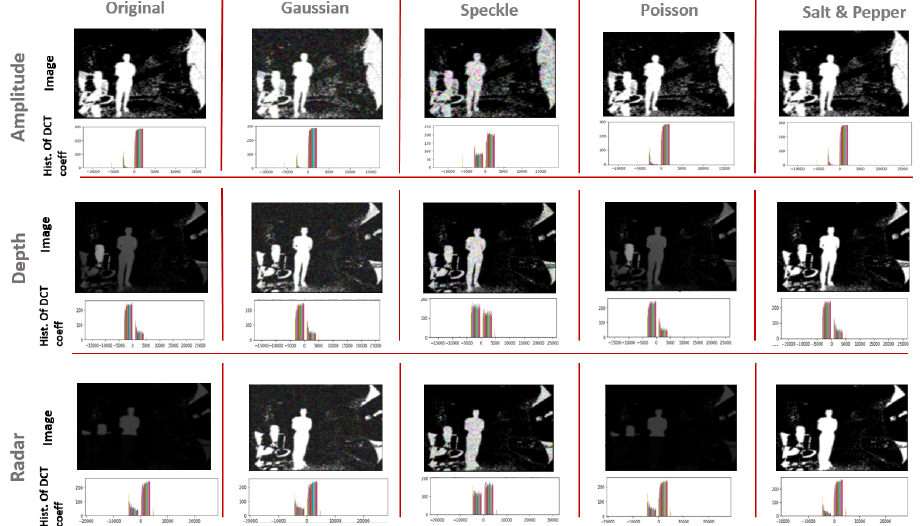
Figure 11. Artificial noise applied to the three different samples amplitude, depth and radar, and their corresponding DCT coefficient.